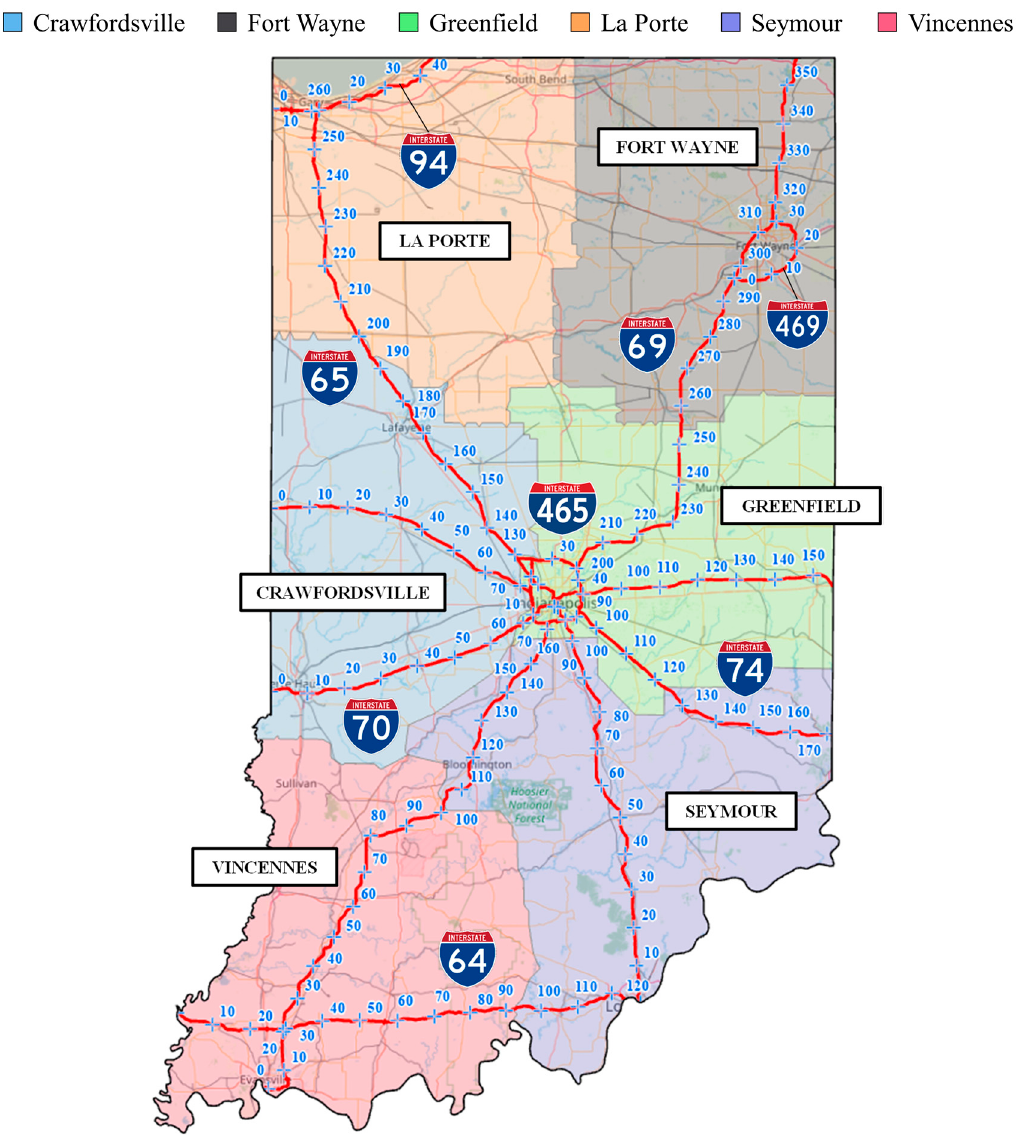
Figure 1. Indiana Interstate System.